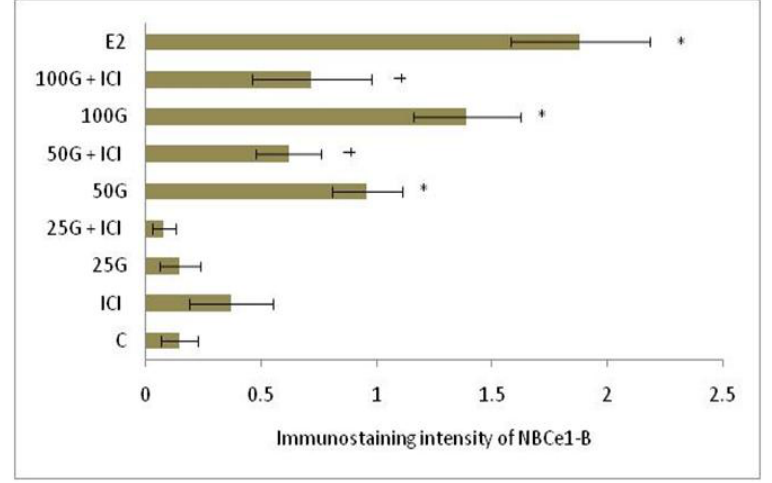
Figure 9. Quantitative analysis of immunostaining intensity of NBCe1-B in the endometrium following treatment with 25, 50 and 100 mg/kg/day genistein and estrogen (positive control) by NIS-Element AR program. The intensity was the highest following estrogen treatment followed by 100 mg/kg/day genistein. C: control; ICI: ICI 182780; 25G: 25 mg/kg/day genistein; 50G: 50 mg/kg/day genistein; 100G: 100 mg/kg/day genistein; E2: estrogen. * p < 0.05 as compared to control; † p < 0.05 as compared to without ICI.